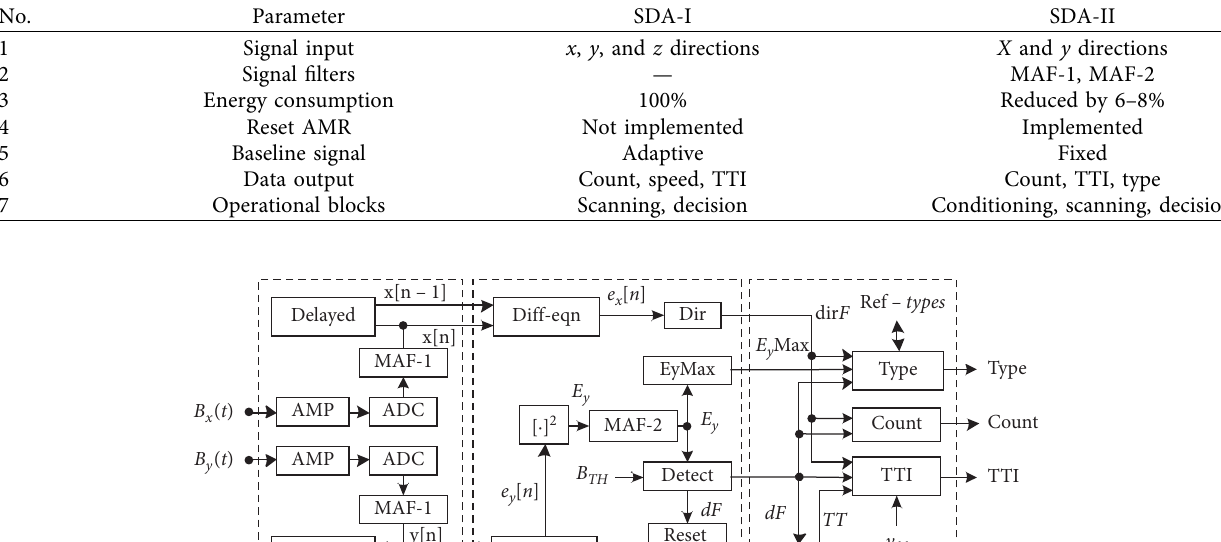
Table 1: Comparisons between SDA-I and SDA-II.